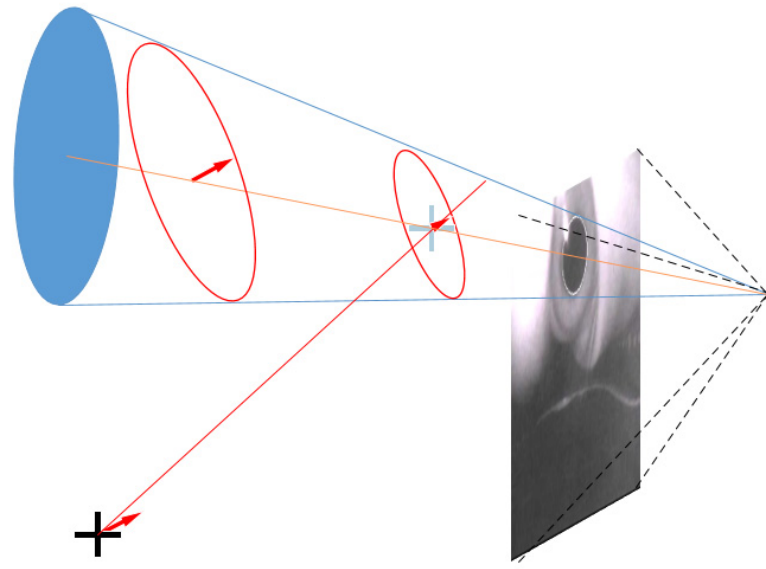
Figure 45. Center of the sphere intersects the gaze point vector [9] .